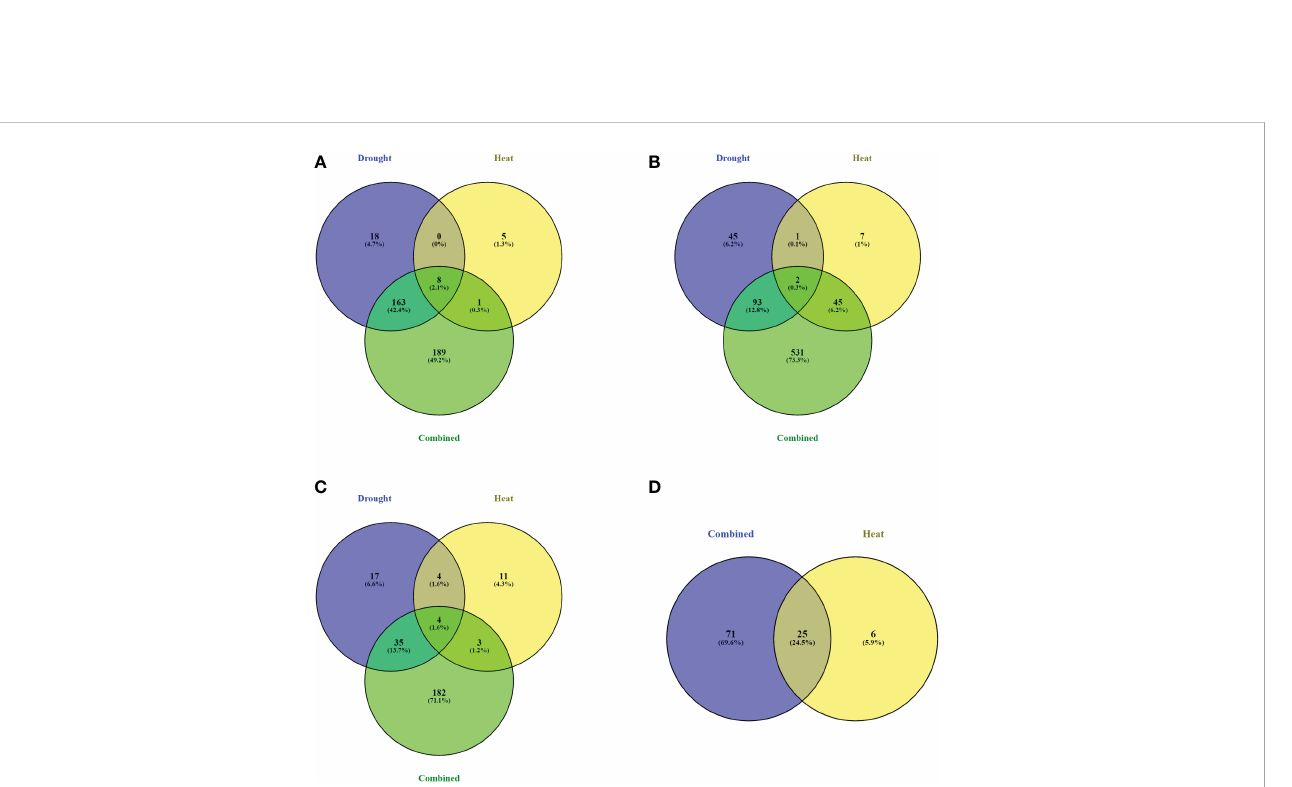
FIGURE 6 Identi fi cation of DEGs common for drought, heat, and combined treatment at each sampling time. Number of DEGs identi fi ed for each treatment at (A) sampling time 3; 11 th day of drought treatment and fi rst day of heat treatment. (B) sampling time 4; 12 th day of drought treatment and second day of heat treatment. (C) sampling time 5; day of stress removal. (D) sampling time 6; physiological